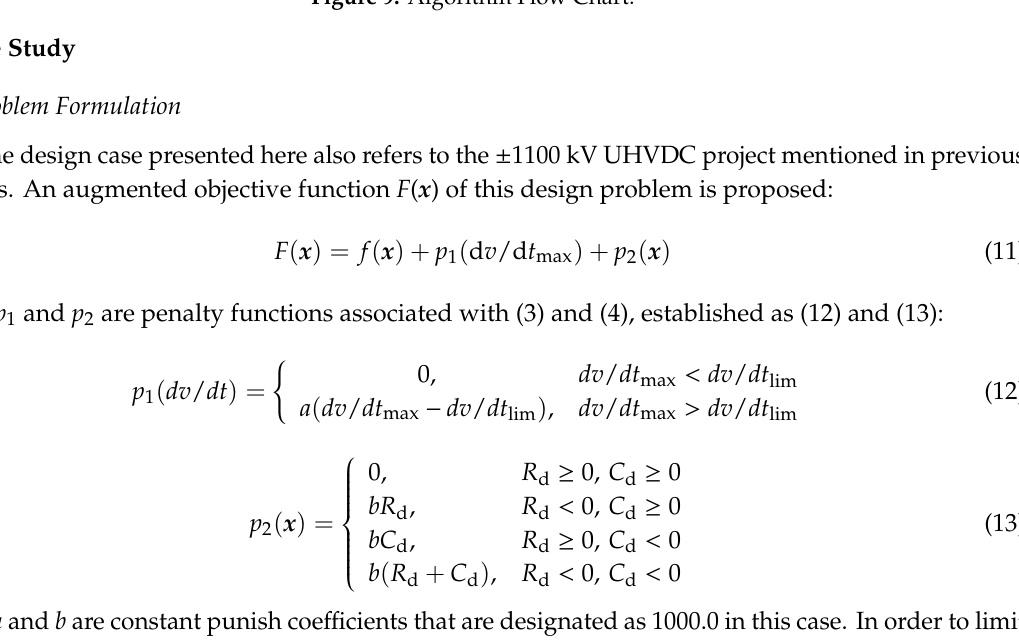
Figure 9. Algorithm Flow